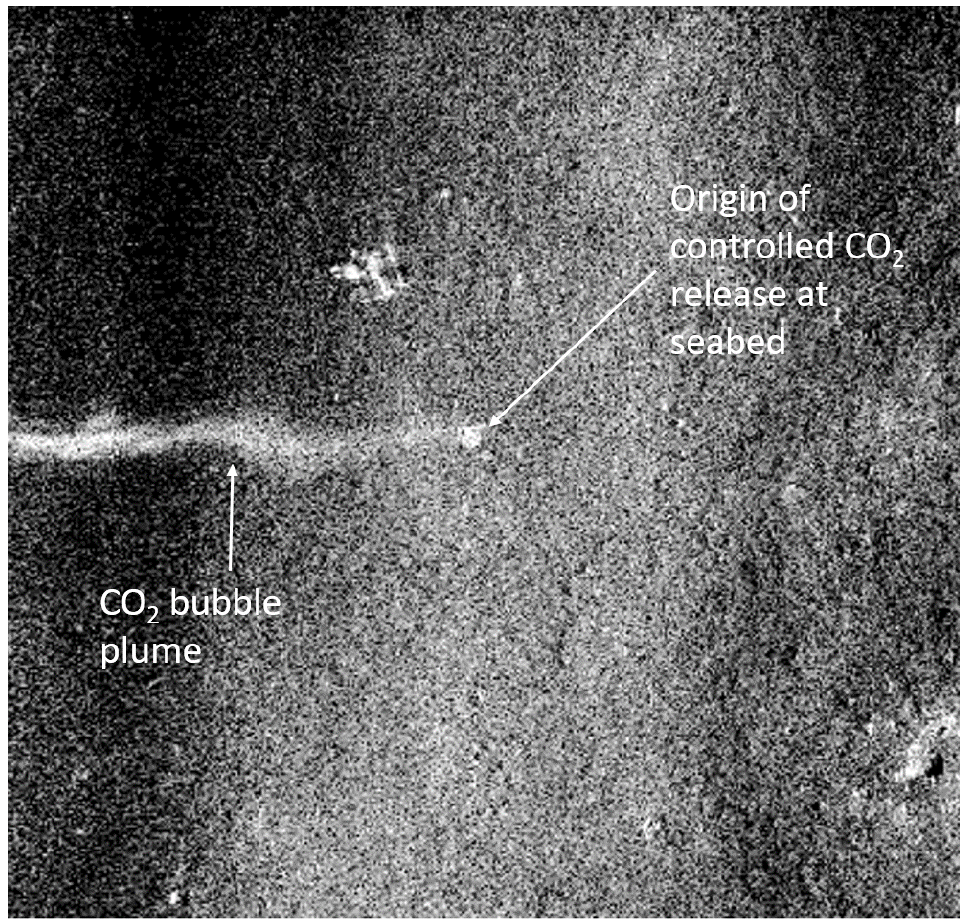
Figure 2. Example image obtained using the HISAS sonar mounted on the HUGIN AUV during the ACT4storage controlled release experiment. The signature of a 1.3 liter/minute release of gaseous CO 2 can be seen as a high-intensity (white) plume originating at the release